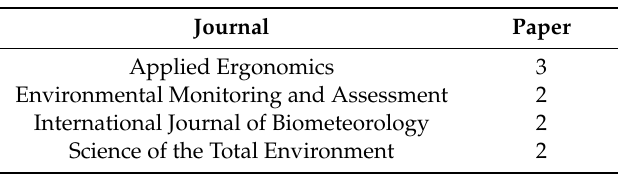
Table 6. Most relevant